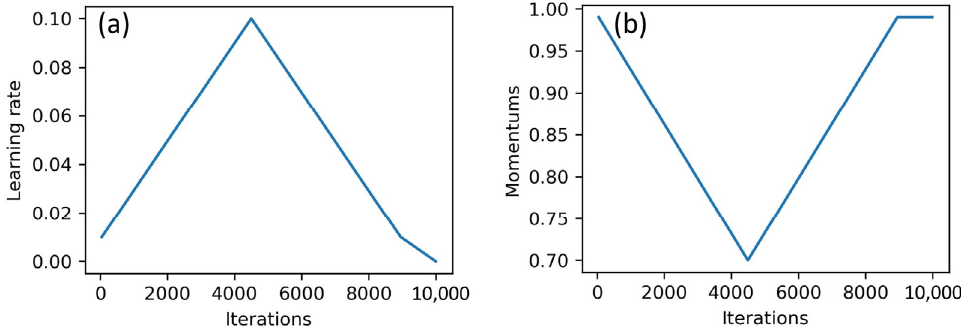
Figure 3. Changes in learning rate ( a ) and momentum ( b ) during the training process.